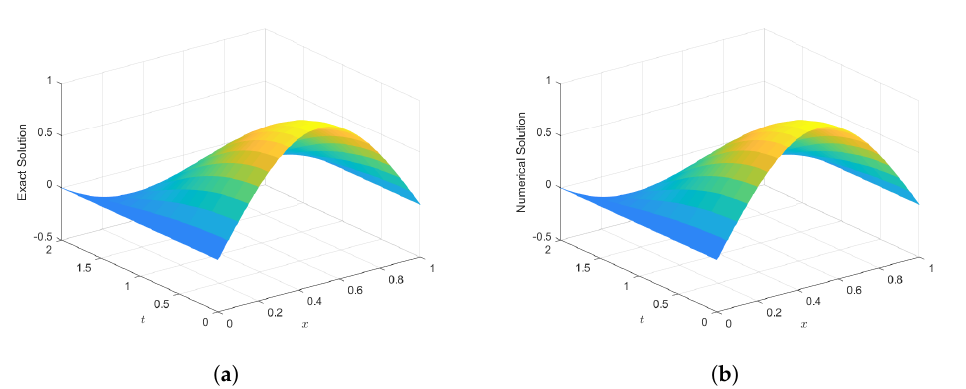
Figure 11. 3D surface plots of the ( a ) exact solution and ( b ) numerical solution vs. x at time 2.0 with ∆ x = 0.05, using the standard finite difference method.